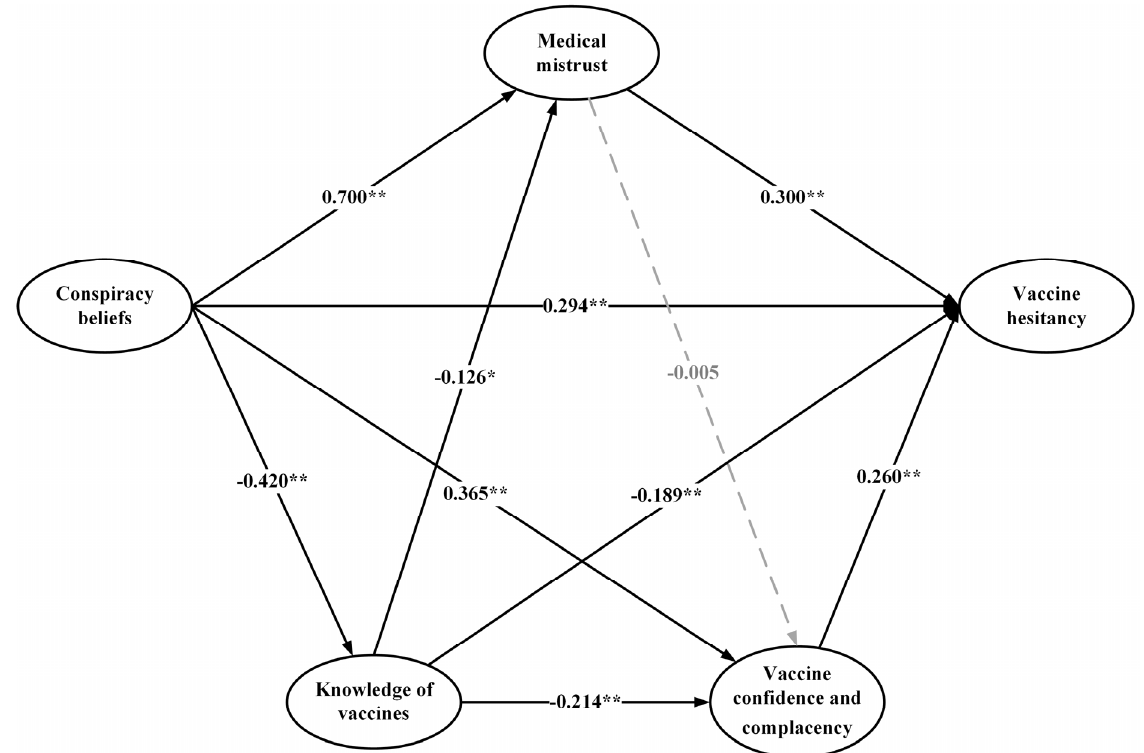
Figure 2. Standardized estimates of the pathways from conspiracy beliefs to Vaccine hesitancy of COVID-19 vaccines in the model. * p < 0.05, ** p < 0.01 Grey arrows refer to nonsignificant direct effects. Fitting of the model: χ 2 /df = 2.464; RMSEA = 0.038; SRMR = 0.050; CFI = 0.930; IFI = 0.930. Table 3. Standardized indirect path effects from conspiracy beliefs to vaccine hesitancy ( N = 1015). Pathways